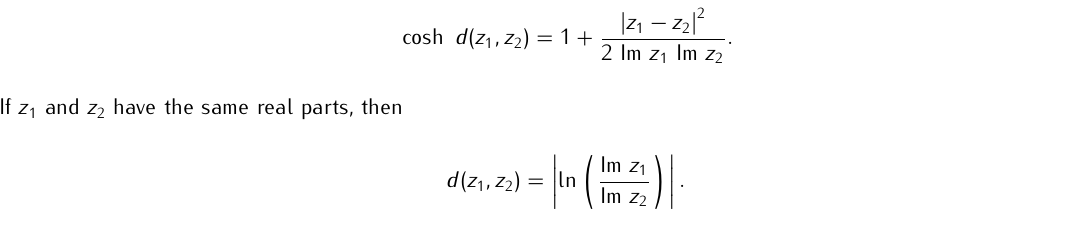
a ( − ¯ z )+ b az + b ad−bc > 0. cz + d or c ( − ¯ z )+ d with real coefficients verifying